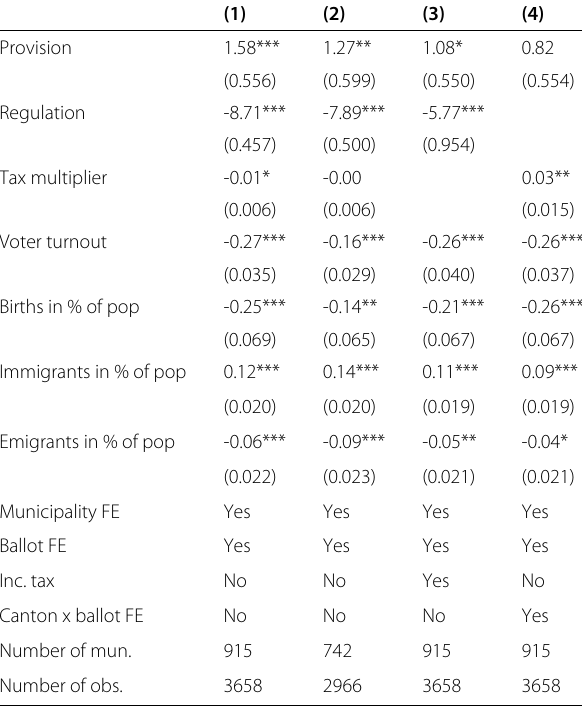
Table 11 DiD estimates: Effect of lunchtime and